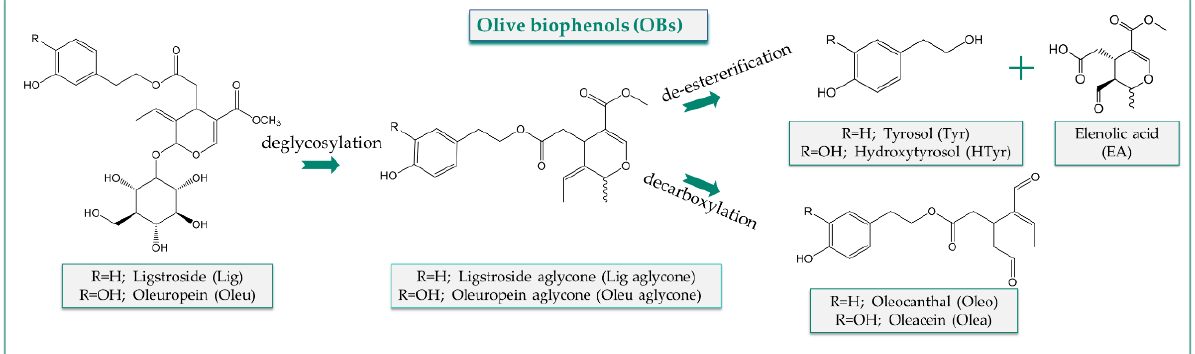
Figure 1. Chemical structures and formation of oleuropein (Oleu) and ligstroside (Lig) aglycones, oleocanthal (Oleo), oleacein (Olea), hydroxytyrosol (HTyr) and tyrosol (Tyr).